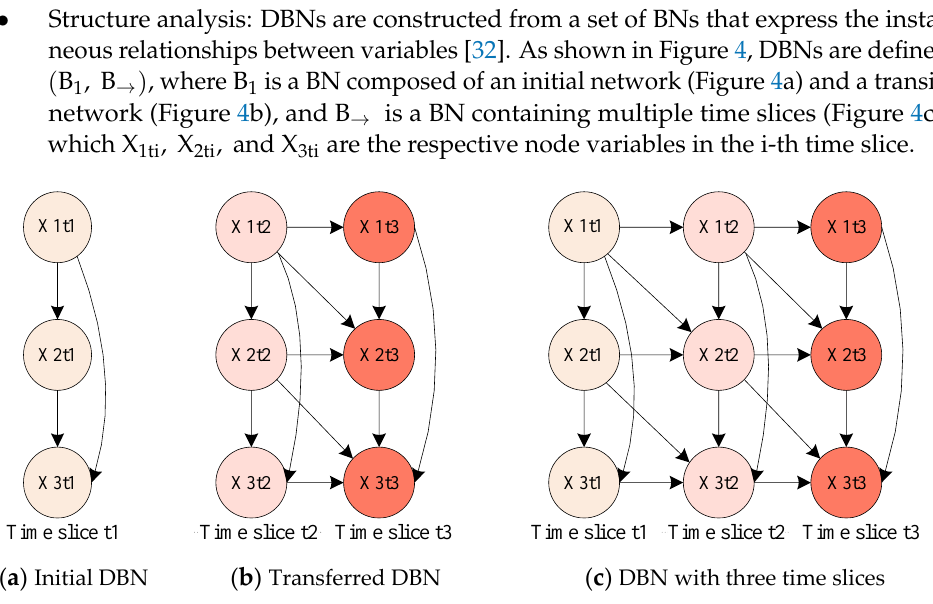
Figure 4. Dynamic Bayesian networks.